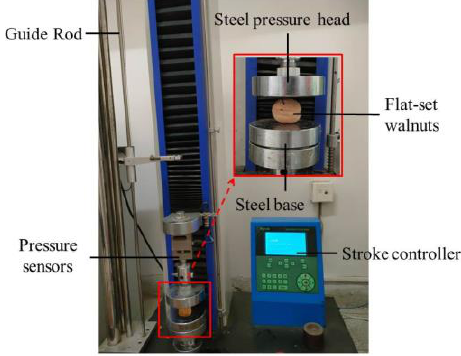
Figure 2. Elastic modulus measurement test.